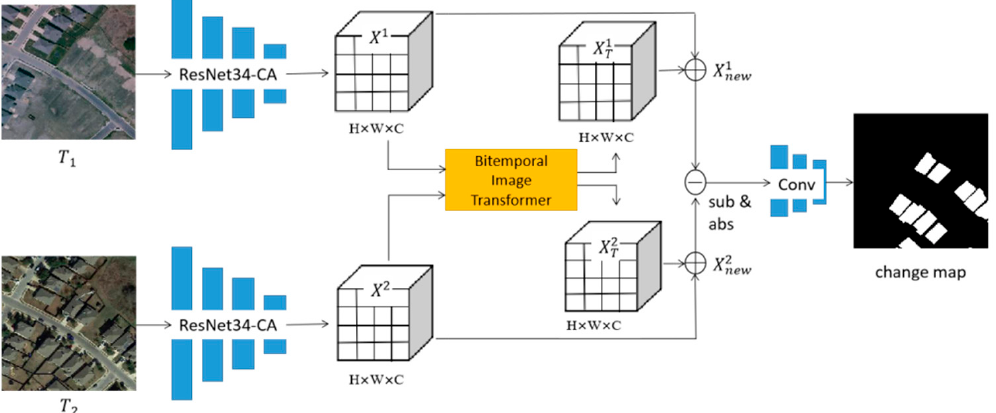
Figure 1. Framework of the CA-BIT model. We first use the image features extracted by the ResNet34-CA backbone. Then, we enhance the image features by the BIT module and fuse the features. Finally, our prediction part produces pixel-level predictions by feeding the computed feature difference images into a shallow CNN.